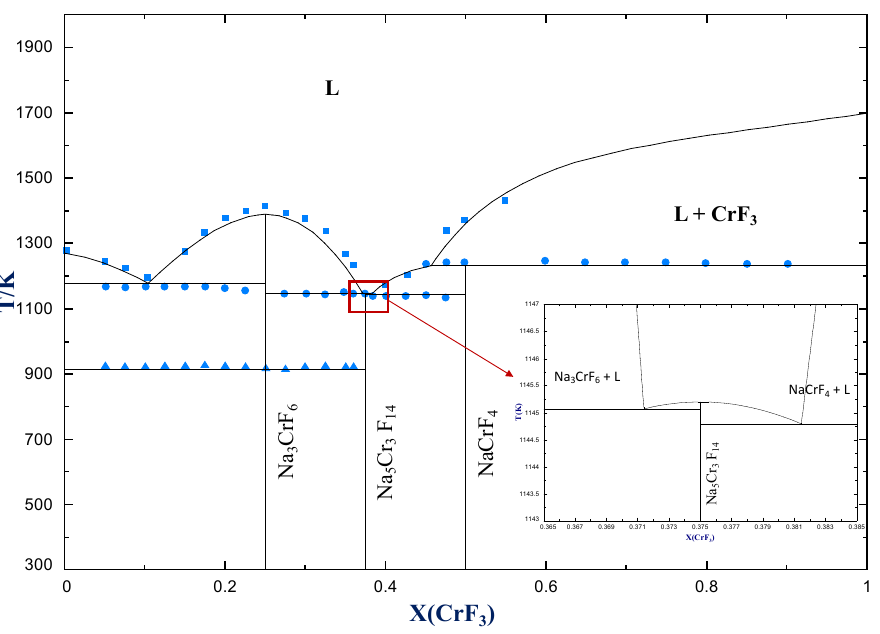
Figure 3. Phase diagram of the NaF–CrF 3 system optimized in this work and comparison with the data provided by de Kozak [15]. Blue squares represent liquidus points, blue circles represent solidus points and blue triangles represent phase transition points. The area 0.365 < X(CrF 3 ) < 0.385 is zoomed in upon in the right